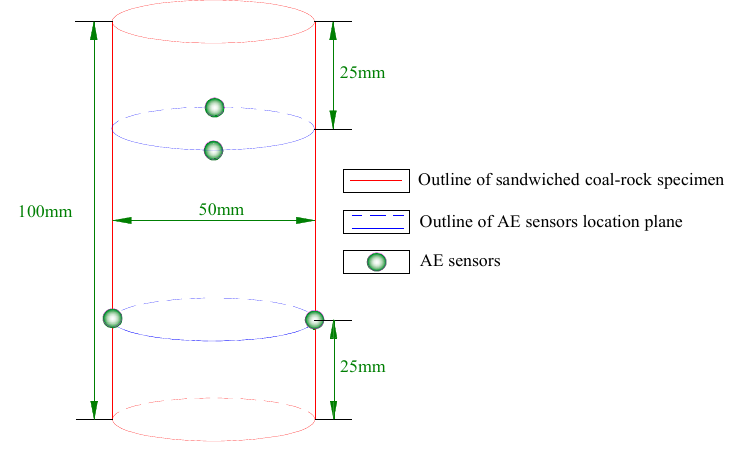
Figure 5. Location of AE sensors in the uniaxial compressive experiment.